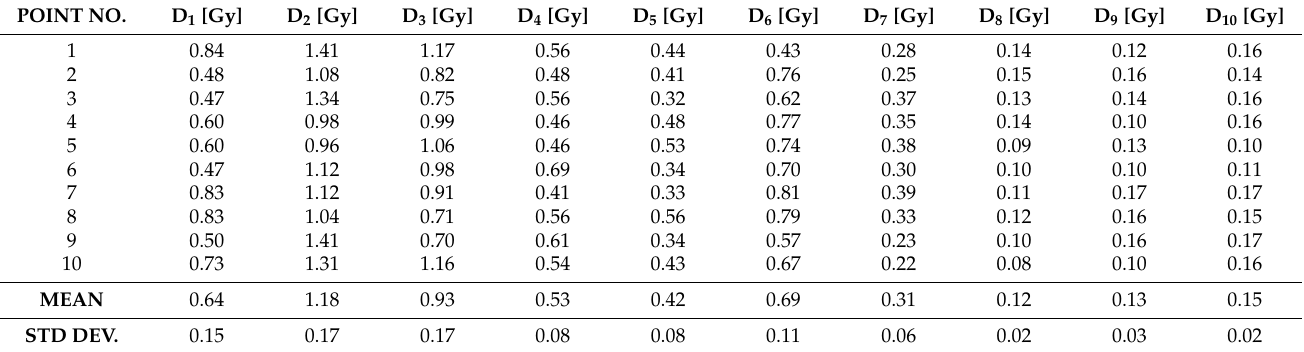
TPS calculated dose values at the point corresponding to the center of the lens were also analyzed depending on the use of the TG186 high-accuracy or TG43 formalism. The observed dose differences are shown in Figure